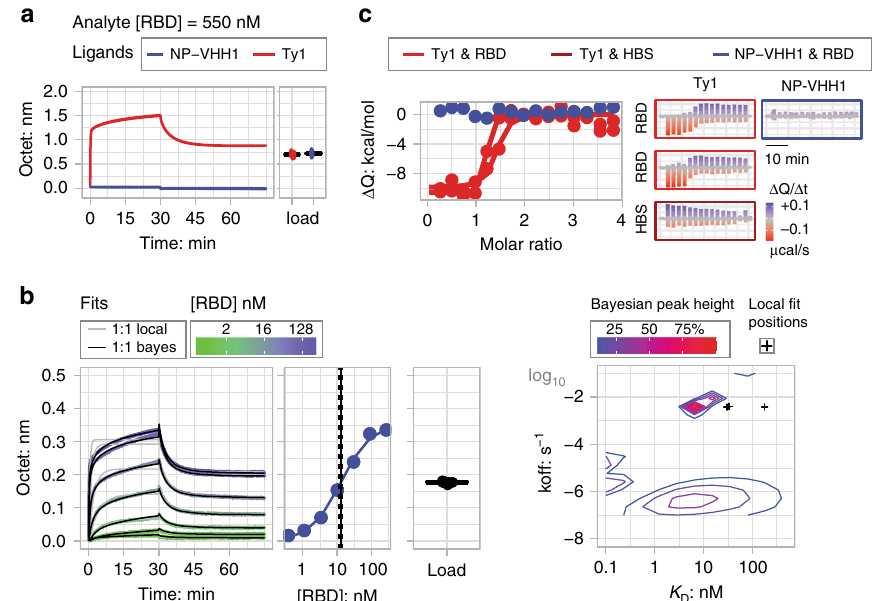
Fig. 3 RBD binds to Ty1 with a K D of 5 – 10 nM. a RBD bound to surface-immobilized Ty1 (red curves), but not to NP-VHH1 (blue curves). Almost equal nanobody immobilization levels of about 0.7 nm were obtained by fi rst loading Ty1 and then NP-VHH1. In bio-layer interferometry (BLI), binding of molecules over time is recorded as sensorgrams recording the shift in wavelengths (unit: nm) due to an increase in the optical thickness of the surface layer. b (1st panel) RBD titration sensorgrams obtained at high salt concentrations revealed concentration-dependent responses. Sensorgrams are color- coded according to the log2 RBD concentration scale. Standard and Bayesian 1:1 binding models are shown as gray and black solid lines. (2nd panel) Pseudo-equilibrium response values plotted against the logarithmic RBD concentration revealed sigmoidal binding curves that were fi t to the single-site interaction model 50 yielding K D -values in the low nM range. K D -values and standard deviations are shown as solid and dotted lines, respectively. (3rd panel) Sensor immobilization levels are shown as jittered box plots. (4th panel) Two-dimensional distribution of dissociation rate ( k off ) and af fi nity ( K D ) values obtained from the Bayesian and standard 1:1 model fi ts, visualized as densities according to depicted normalized height scale and single black crosses, respectively. See related Supplementary Fig. 1a. Plots for RBD/Ty1 titrations at normal salt condition with same legends and scales. c (1st panel) ITC demonstrated high-af fi nity binding of Ty1 to RBD with fi tted K D and binding enthalpy ( Δ H) mean values of 9 nM (with estimated bounds of 1 and 70 nM) and − 10 ± 0.5 kcal/mole (mean value ± standard deviation), respectively, for two binding experiments (red). Injection of NP-VHH1 into RBD yielded heat changes at background level (blue). (2nd panel) Baseline-corrected heat changes plotted for two Ty1/RBD, a single Ty1/HBS buffer, and NP-VHH1/ RBD titration experiments. Negative and positive heat changes are colored according to the red-to-blue gradient. See related Supplementary Fig. 1b: Same fi gure on larger scale to highlight the Ty1 into buffer dilution curves revealed sigmoidal line-shapes with fi tted apparent K D - values of 8 ± 1.5 and 13 ± 1.5 nm (mean value ± standard devia- tion) for binding at normal and high salt conditions, respectively.